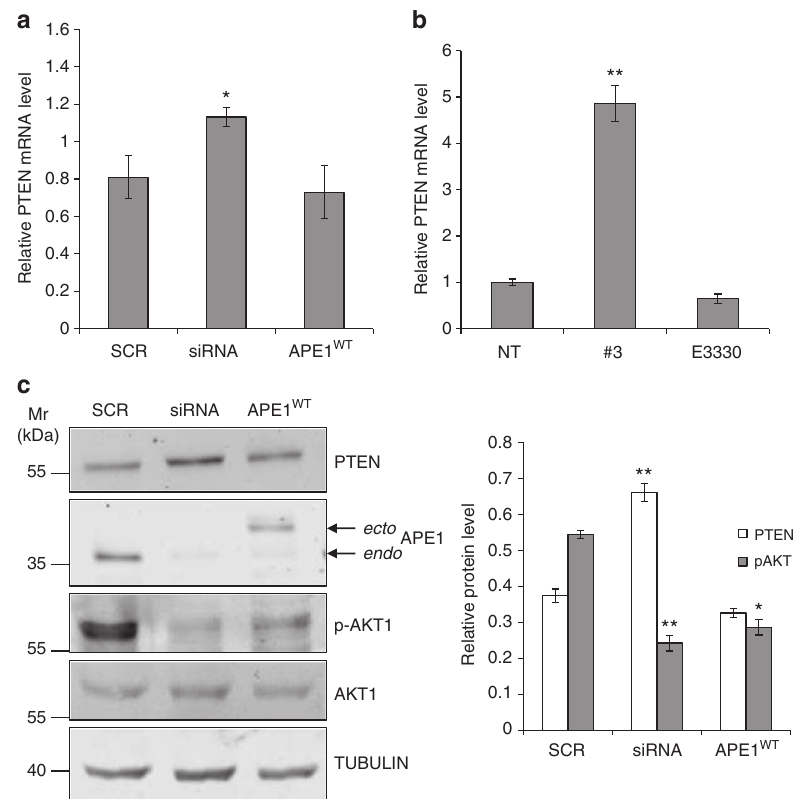
Fig. 5 Impact of miR-221/222 processing on PTEN protein expression. a PTEN mRNA levels evaluated by qRT-PCR analysis of HeLa cell clones silenced for APE1 expression. Total RNA was extracted from HeLa cell clones expressing APE1 WT or APE1 silenced (siRNA) and reverse transcribed. Histogram shows the detected levels of PTEN normalized to GAPDH levels. Asterisks represent a signi fi cant difference with respect to control (SCR).* P < 0.05, Student ’ s t -test. b PTEN mRNA levels evaluated by qRT-PCR analysis of HeLa cell treated with 20 µ M compound #3 or 100 µ M E3330 for 24 h, respectively. Histogram shows the detected levels of PTEN normalized to GAPDH levels. Asterisks represent a signi fi cant difference with respect to control (NT). ** P < 0.001, Student ’ s t -test. c PTEN protein level evaluated in HeLa cell clone silenced for APE1 expression. Representative western blotting analyses of total cell extracts of HeLa cell clones. PTEN expression inversely correlates with phosphorylation of Akt1 ( pAkt1 ). Histogram reports expression level of PTEN and pAkt protein obtained after quanti fi cation of the signal intensity of the corresponding bands. Data represent the means of ± SD of three independent experiments. Tubulin was used as loading control and for data normalization. Asterisks represent a signi fi cant difference with respect to control (SCR).* P < 0.05, ** P < 0.001, Student ’ s t